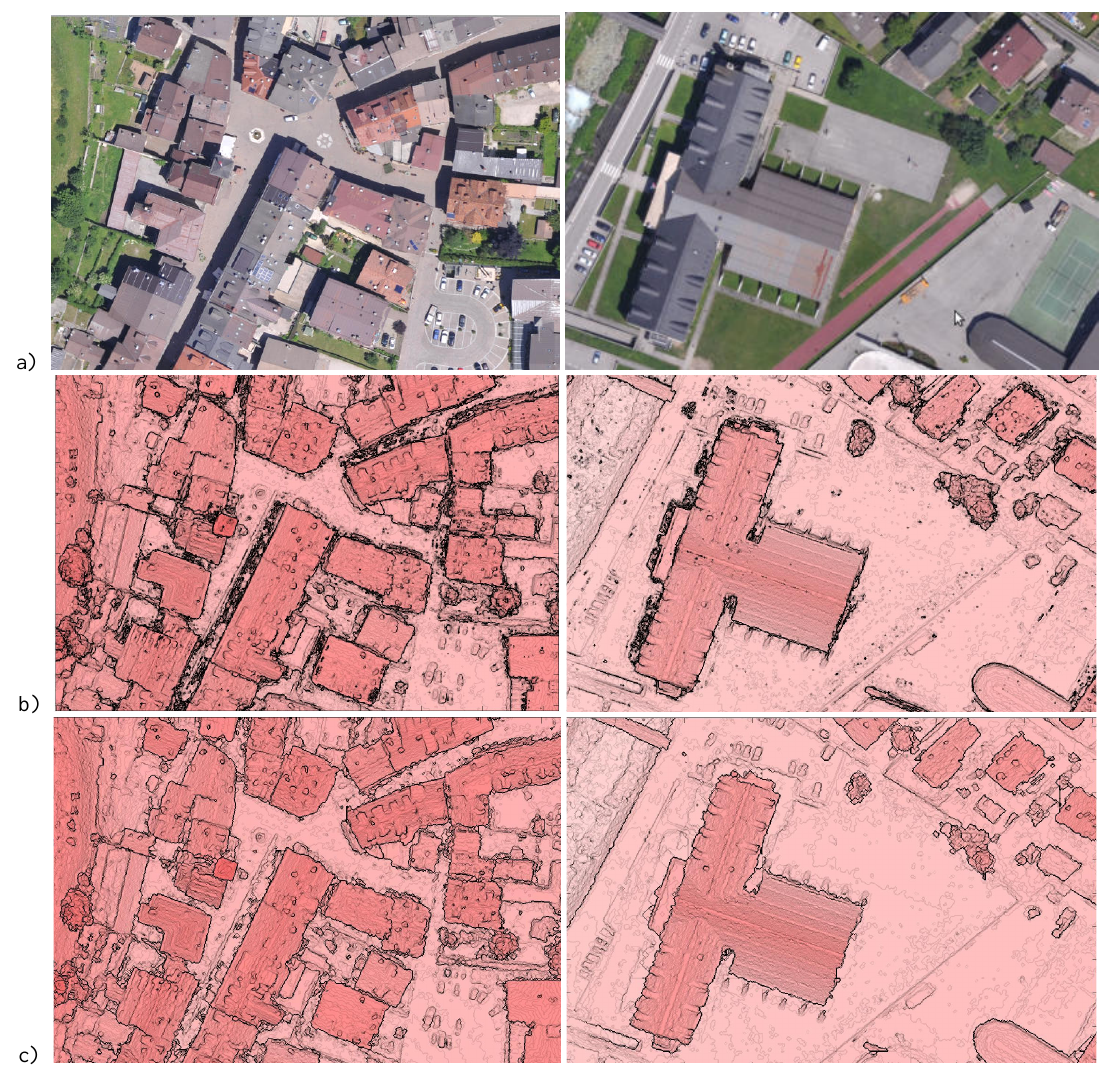
c) Figure 8: Qualitative comparison of real case: the true ortho-photo of the area (a), the DSM before (b) and after (c)